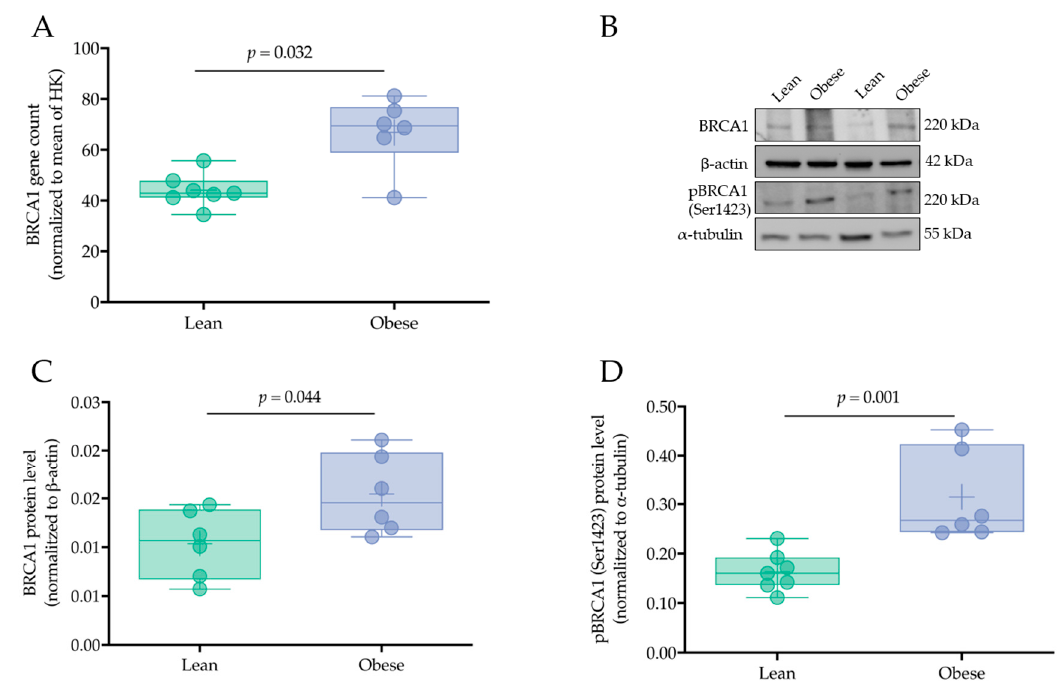
Figure 3. Placental BRCA1 is upregulated by maternal obesity. BRCA1 expression and protein levels were determined in first trimester placental tissue (gestational week 7) from lean ( n = 6–7) and obese ( n = 6) women by Nanostring ( A ) and Western blotting ( B – D ), respectively. Gene counts of Nanostring analysis were normalized to the mean of two different housekeeping (HK) genes (WD repeat domain 45B ( WDR45L ) and TATA box binding protein ( TBP , A ). Immunoblots for BRCA1 and p (Ser1423) -BRCA1 ( B ) were quantified by densitometric analysis ( C and D ). β -actin and α -tubulin were used for normalization as loading controls. Results are presented as mean ± SD. Statistical analysis was performed using the Mann Whitney test or t -test as appropriate.